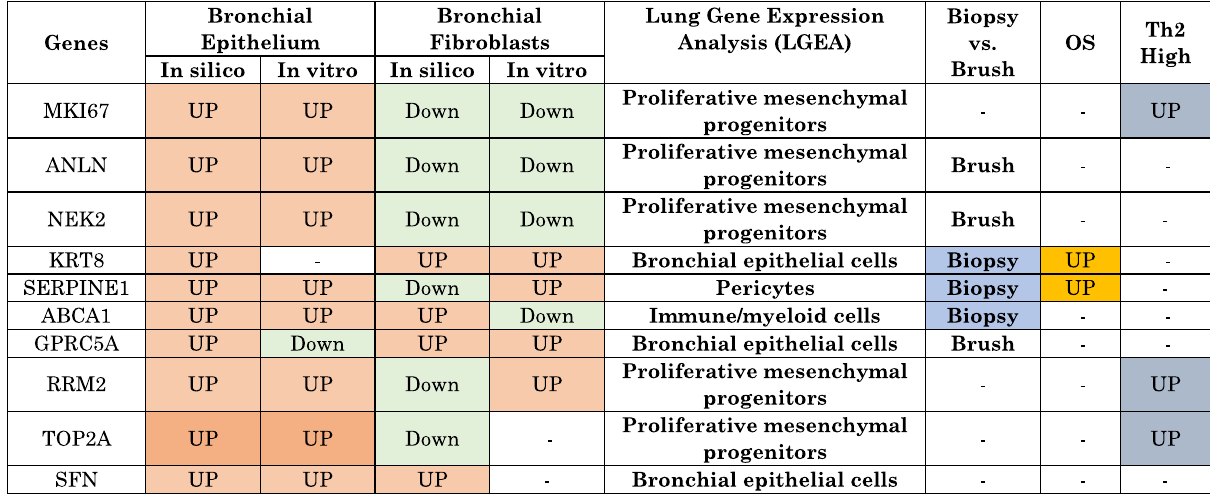
Table 2. Summary of in silico and in vitro analysis of the ten genes in bronchial epithelium and fibroblasts of asthmatic patients. If their expression is specific to bronchial brush or biopsy or not, their response to oral steroids (OS) and their expression level in Th2 high versus Th2 low asthma.